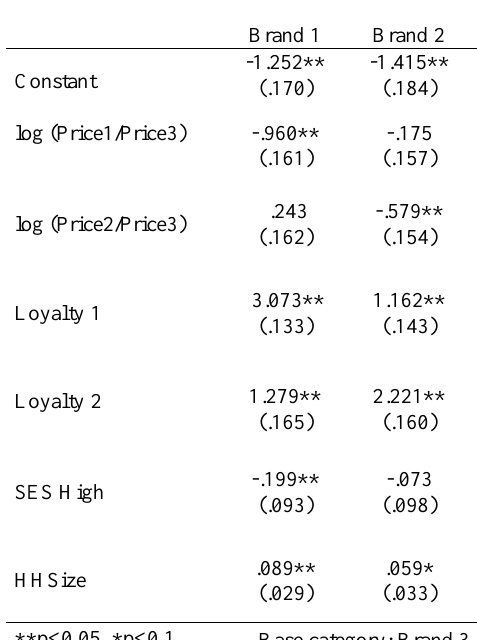
Table 3 Estimation results for the MNP model